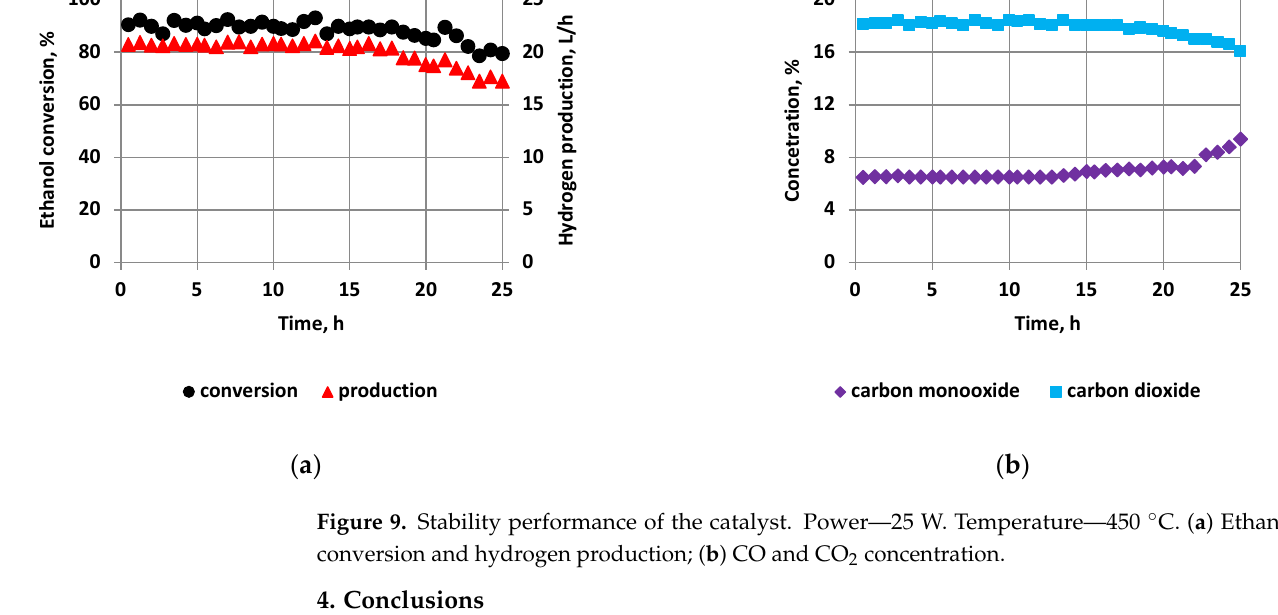
Figure 8. TPO profiles of the carbon deposited on the used catalyst. Power—25 W. Temperature— 500 °C.